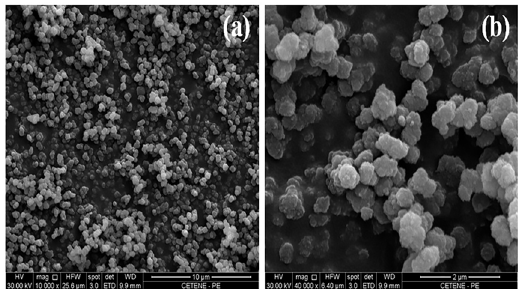
Figure 2. SEM micrographs for ZnS nanoparticles in a)10,000x and b) 40,000x. TEM analysis evidenced ZnS crystals with diameters ranging from 2 to 3 nm . (Figure 3a). Qualitative EDS analysis revealed S and Zn peaks, further confirming the samples identity, as shown in Figure 3b.